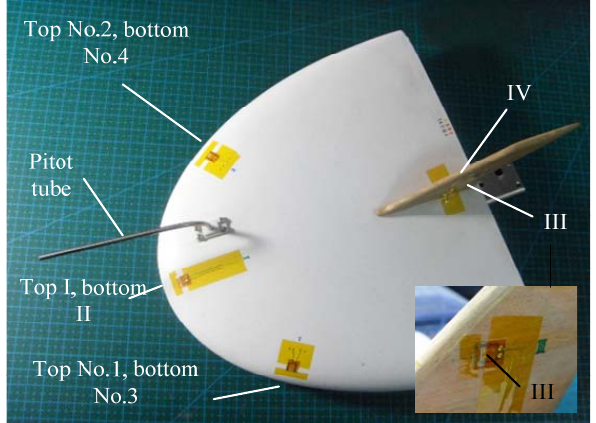
Figure 1. The collocation of hot film flow sensor array on a